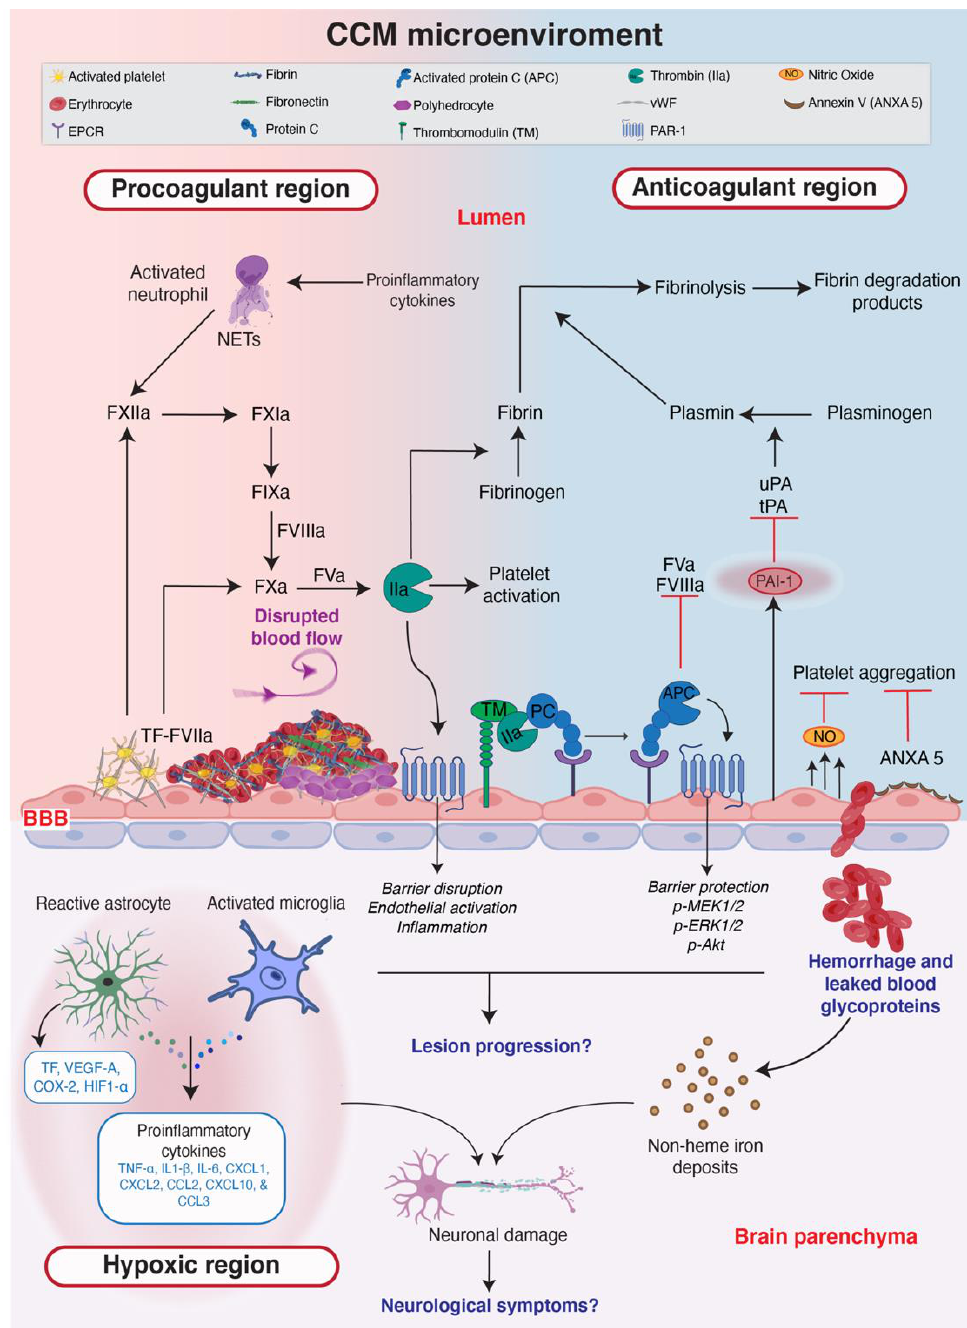
Figure 2. The CCM microenvironment. A schematic representation of the CCM microenvironment of procoagulant (red) and anticoagulant (blue) regions, where endothelial cells are the key regulators of hemostasis, neuroinflammation and bleeding. Endothelial cells interact with blood cells and glycoproteins to regulate coagulation and anticoagulation. CCM-deficient endothelial cells cannot maintain a hemostatic balance and this results in neuroinflammation and hypoxia in the brain parenchyma (light purple). Neuroinflammation, hypoxia and bleeding are all hallmarks of CCM. A simplified version of the coagulation cascade is shown in the lumen and clinical aspects of cavernomas are written in dark blue. Tissue Factor (TF); Urokinase plasminogen activator (uPA); Tissue plasminogen activator (tPA); Neutrophil extracellular traps (NETs); Blood-brain barrier (BBB). The figure was assembled with Adobe Illustrator and BioRender (agreement number QG24D9MLOD).